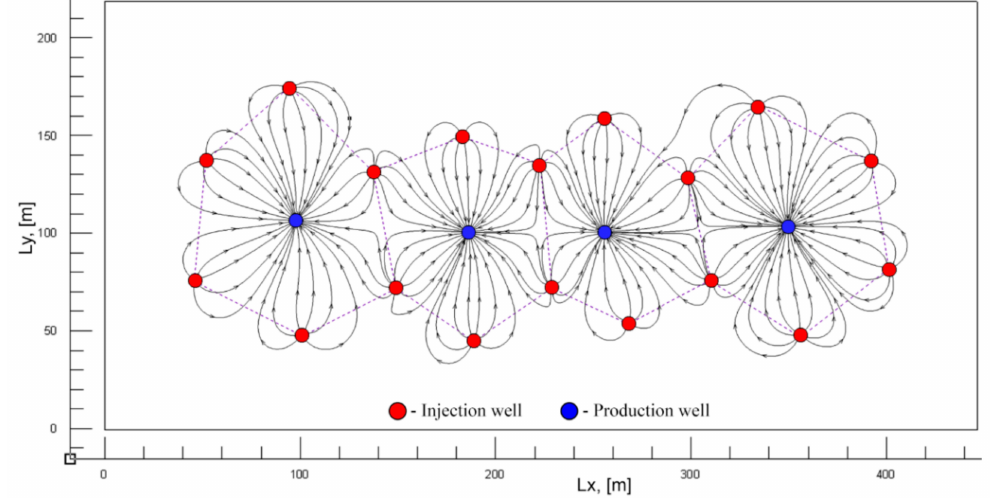
Figure 15. Hexagonal exploitation pattern showing injection (red) and producer (blue) wells together with flow streamlines calculated from injection/pumping conditions imposed on wells. L x and L y [m] denote the length extensions of the study domain,